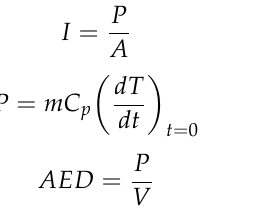
Figure 4. Classification of ultrasound waves according to their usage in food science.